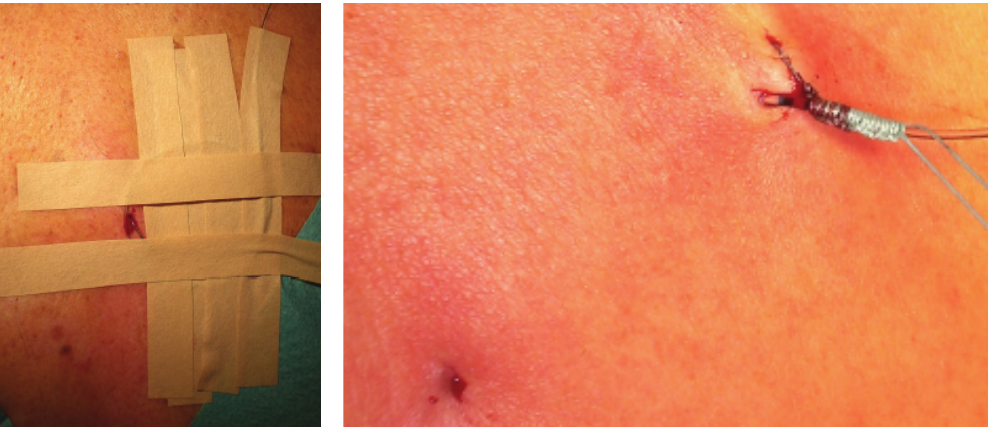
Figure 2: Different fixation techniques. Fixation by taping (left) and tunneling and suturing (right). For further information please refer to the